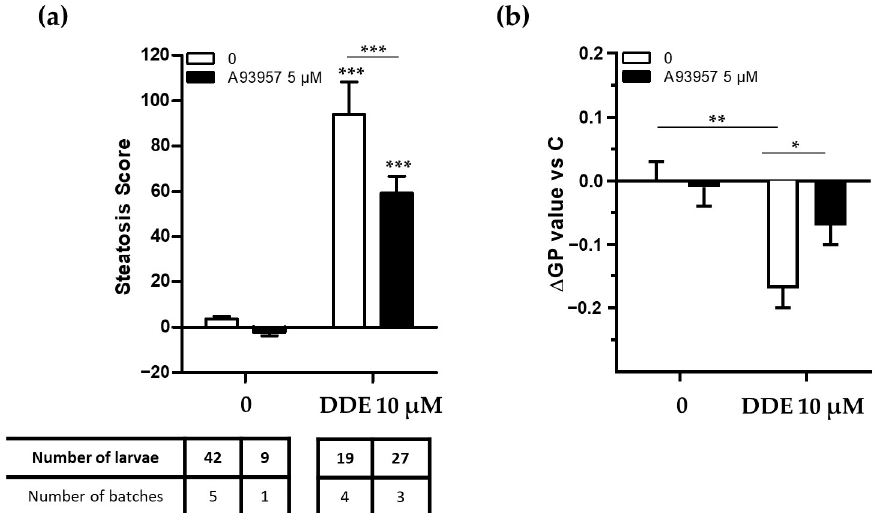
Figure 9. SCD1 inhibition decreases hepatic lipid accumulation and membrane remodeling after exposure to DDE. Zebrafish transgenic larvae at 3 days post-fertilization were co-exposed to a specific SCD1 inhibitor (A939572 5 µ M) and to DDE (10 µ M) during 48 h. ( a ) For the steatosis score evaluation, larvae were euthanized following exposure and fixed, and steatosis scores (based on lipid fluorescence intensity, lipid droplet density, and area in the liver) were calculated based on Nile red staining and image-based automated analysis after confocal microscopy acquisition. Values are mean +/ − SEM; with the number of batches and larvae indicated in the table underneath the graph *** p < 0.001, by comparison with control group using two-way ANOVA and Bonferroni tests. ( b ) Membrane order was assessed in liver cells of zebrafish larvae after staining with di-4-ANEPPDHQ—a membrane order-sensitive fluorescent probe—and analyzed by confocal fluorescence microscopy. Membrane order in membranes of zebrafish liver was measured by computing the generalized polarization (GP) factor. Changes in GP values ( Δ GP) were expressed as the difference between individual larva GP value and the mean GP measured in control larvae (DMSO). Values are mean +/ − SEM for n ≥ 3 batches per conditions. * p < 0.05, ** p < 0.01, by comparison with all groups using ANOVA and Newman–Keuls